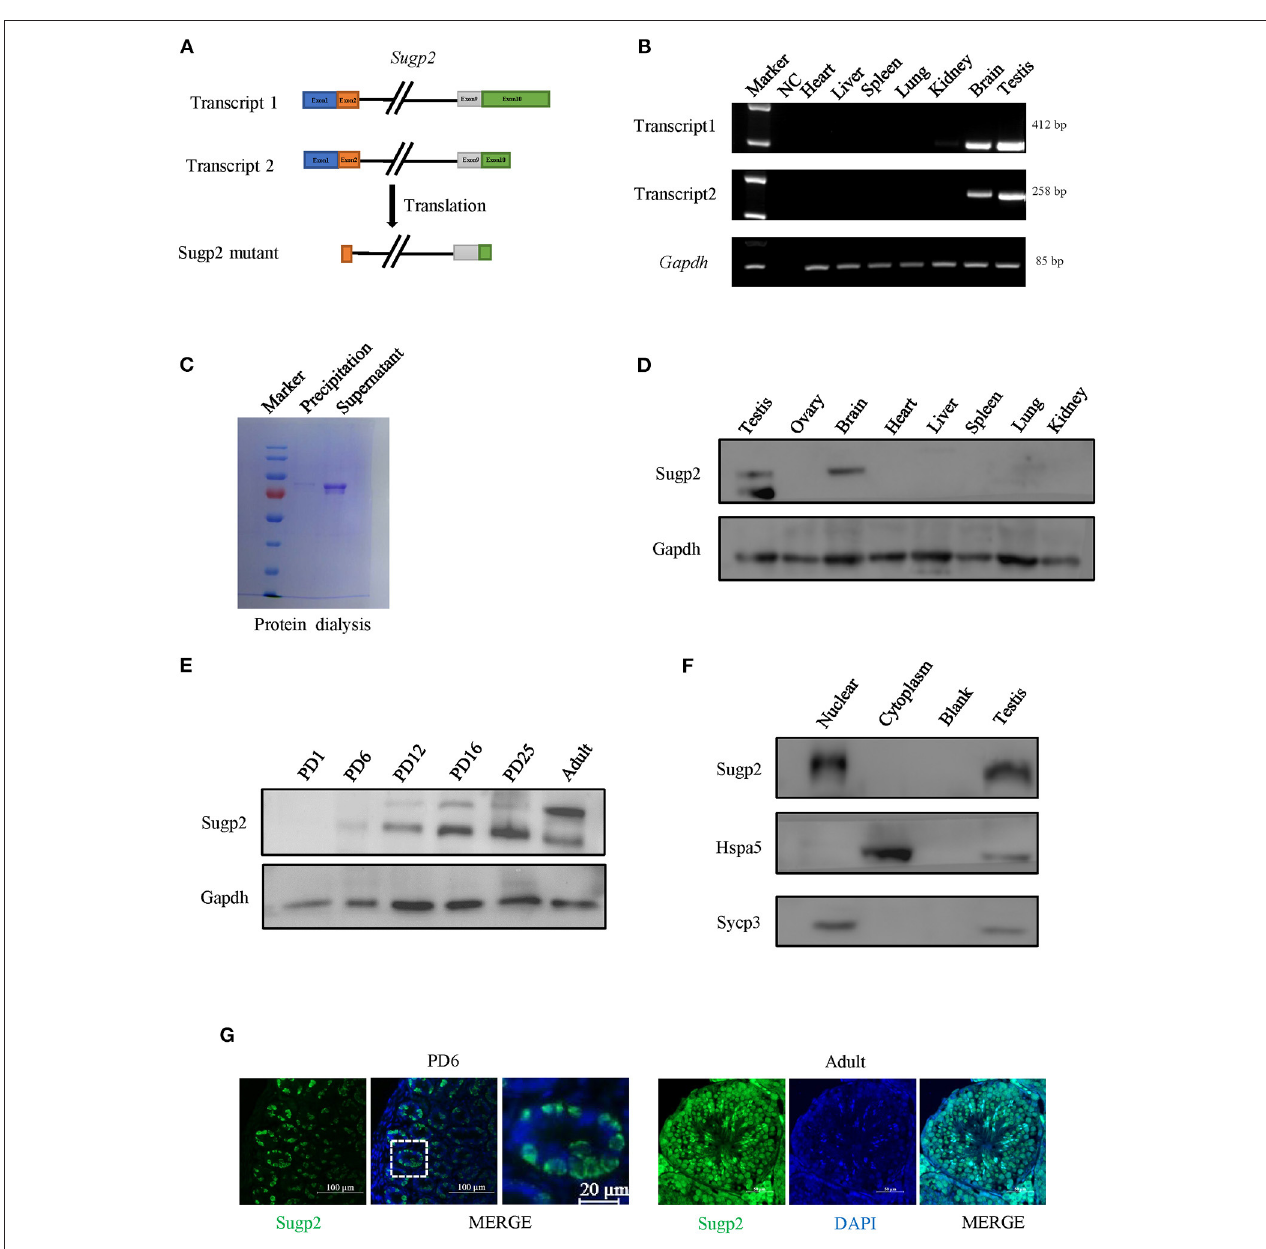
FIGURE 2 | Expression of Sugp2 during mouse spermatogenesis. (A) Transcription and translation information of Sugp2. (B) Identification of Sugp2 isoforms by RT-PCR. (C) Purification of Sugp2 antigen by dialysis. The expression pattern of Sugp2 in different tissues (D) and testes at different stages (E) . The expression of Sugp2 in mouse testis was confirmed by western blot (F) and immunofluorescence (G) .